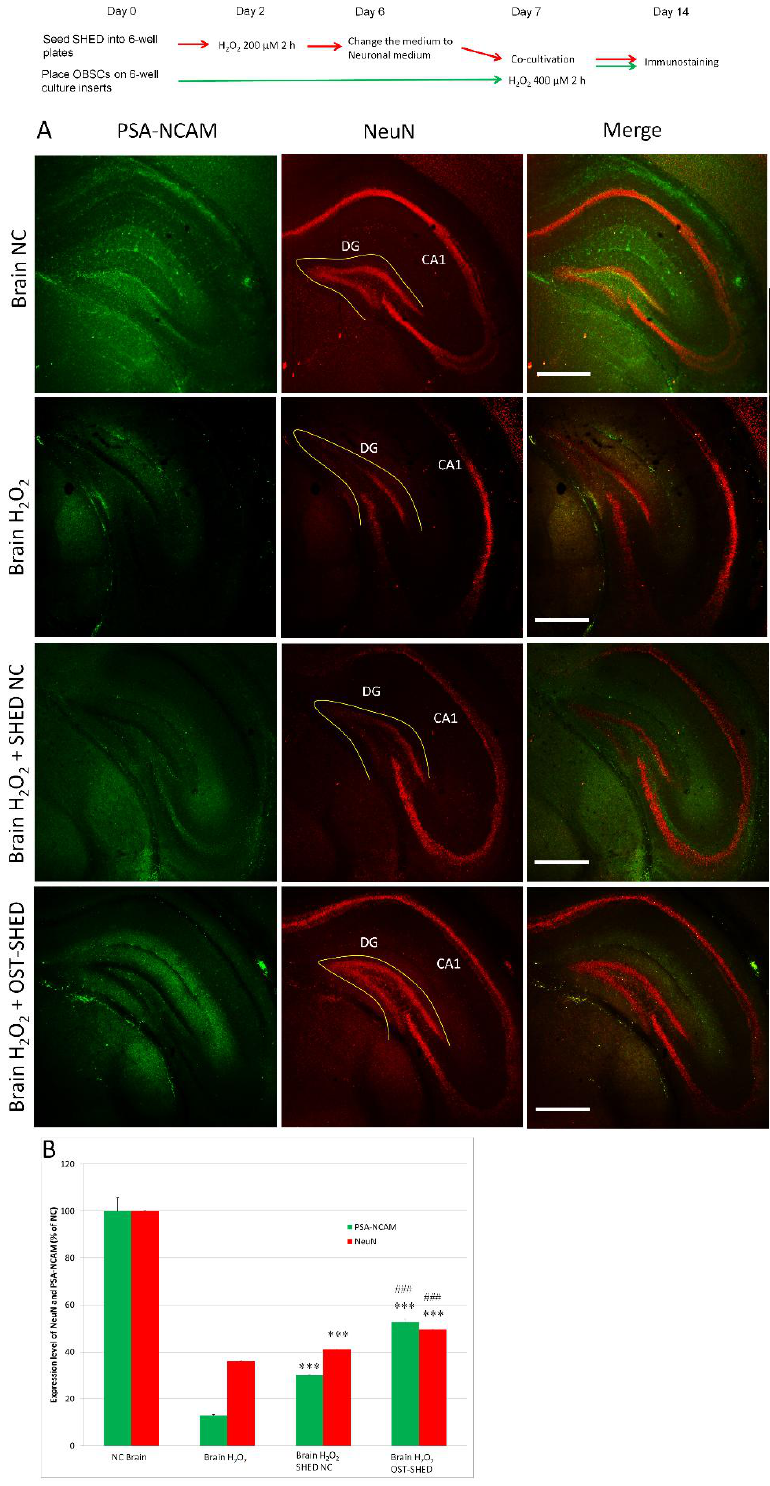
Figure 3. Expression of PSA-NCAM and NeuN in OBSCs. At the end of cultivation (day 14), OBSCs were fixed with 4% paraformaldehyde and followed by immunostaining. ( A ), Typical images of the expression of PSA-NCAM (neuronal regeneration maker) (green) and NeuN (mature neuron marker) (red) in the hippocampus region in OBSCs. DG, dentate gyrus; ( B ), Expression level of PSA-NCAM and NeuN in OBSCs were analyzed with Image J software by quantifying the fluorescence density. Data are presented as mean ± SD. *** p < 0.001 v.s. Brain H 2 O 2 , ### p < 0.001 v.s. Brain H 2 O 2 SHED NC.